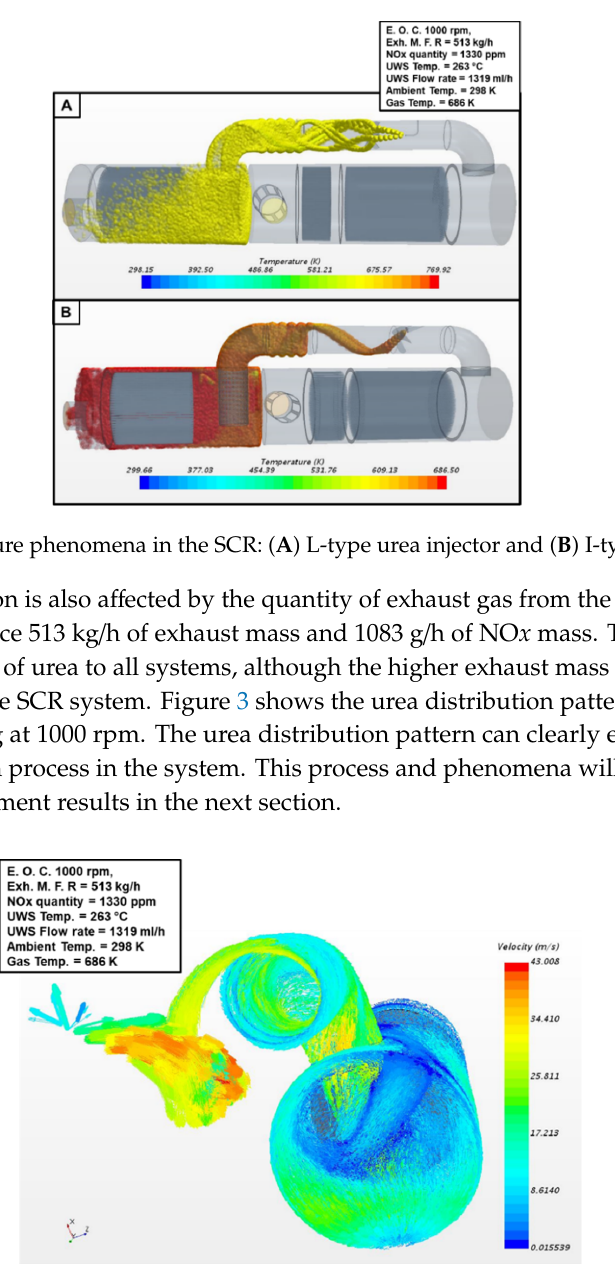
Figure 1. Urea distribution phenomena in the SCR system: ( A ) L-type urea injector and ( B ) I-type urea injector.